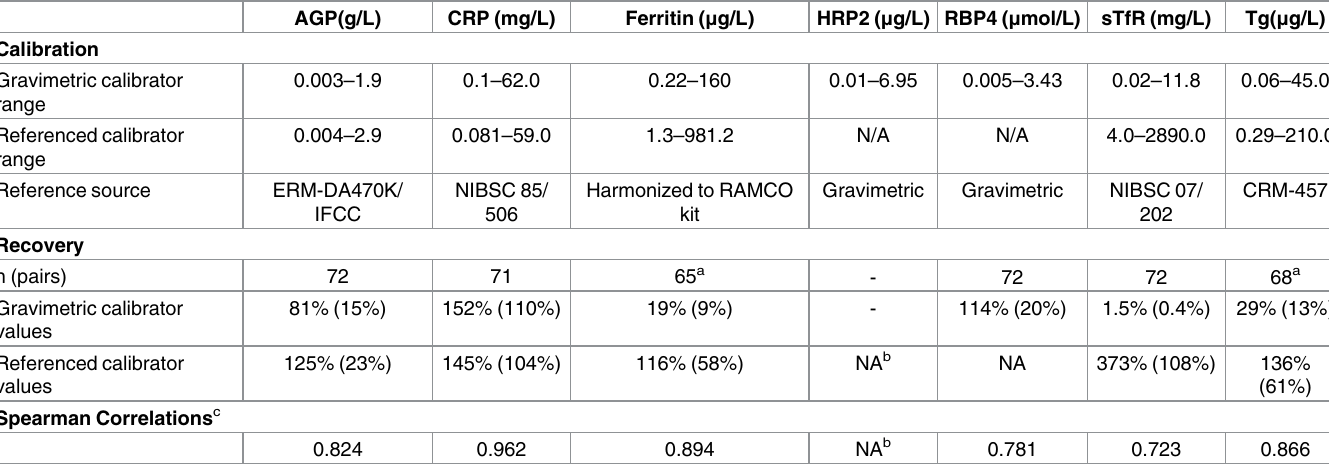
Table 2. 7-Plex assay calibration ranges and recovery via comparisons with conventional ELISAs from USA donor training panel